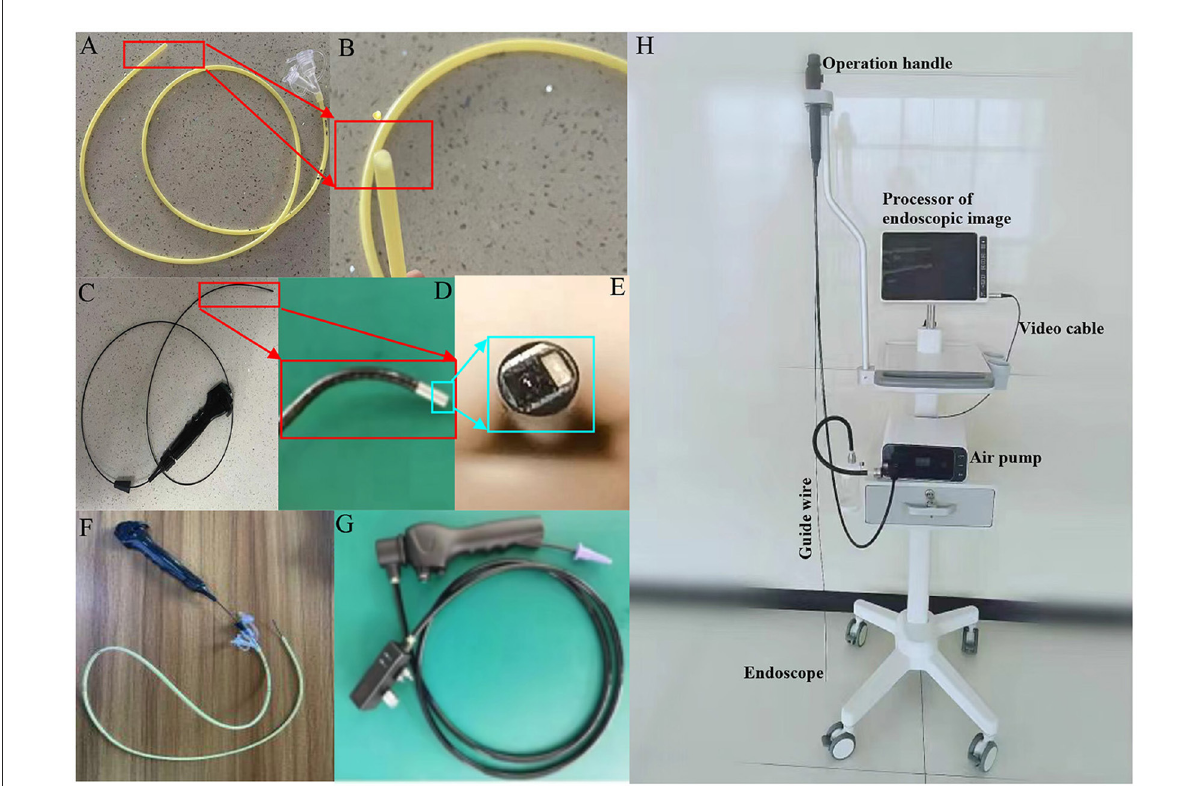
FIGURE1 The system for endoscopic placement of nasojejunal feeding tubes. (A) A nasojejunal feeding tube. (B) The bullet shaped tip of the feeding tube. (C) Operable handle, guide wire, and endoscope connected with another end of the wire. (D) The end of guide wire and endoscope. (E) The tip structure of an endoscope. (F) The assembly is composed of an operable handle, guide wire, an endoscope, and a nasojejunal feeding tube. (G) Power cord and an operation handle. (H) The instrument of for endoscopic placement of feeding